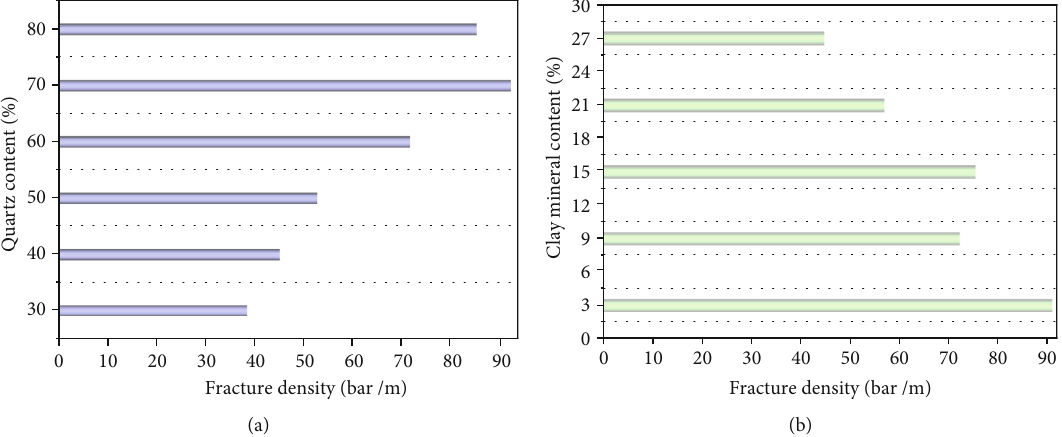
Figure 4: Relationship between mineral properties, content, and fracture density: (a) the relationship between quartz content and natural fracture density and (b) the correlation between clay mineral content and natural fracture